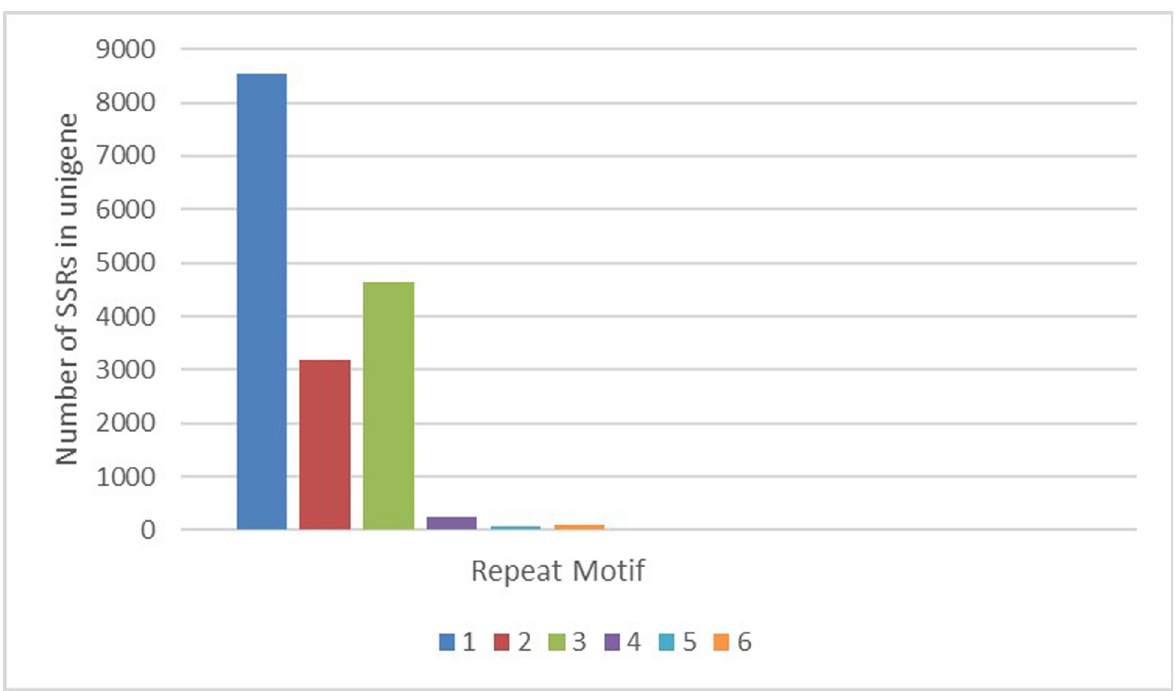
Fig 1. Distribution to different repeat type classes in